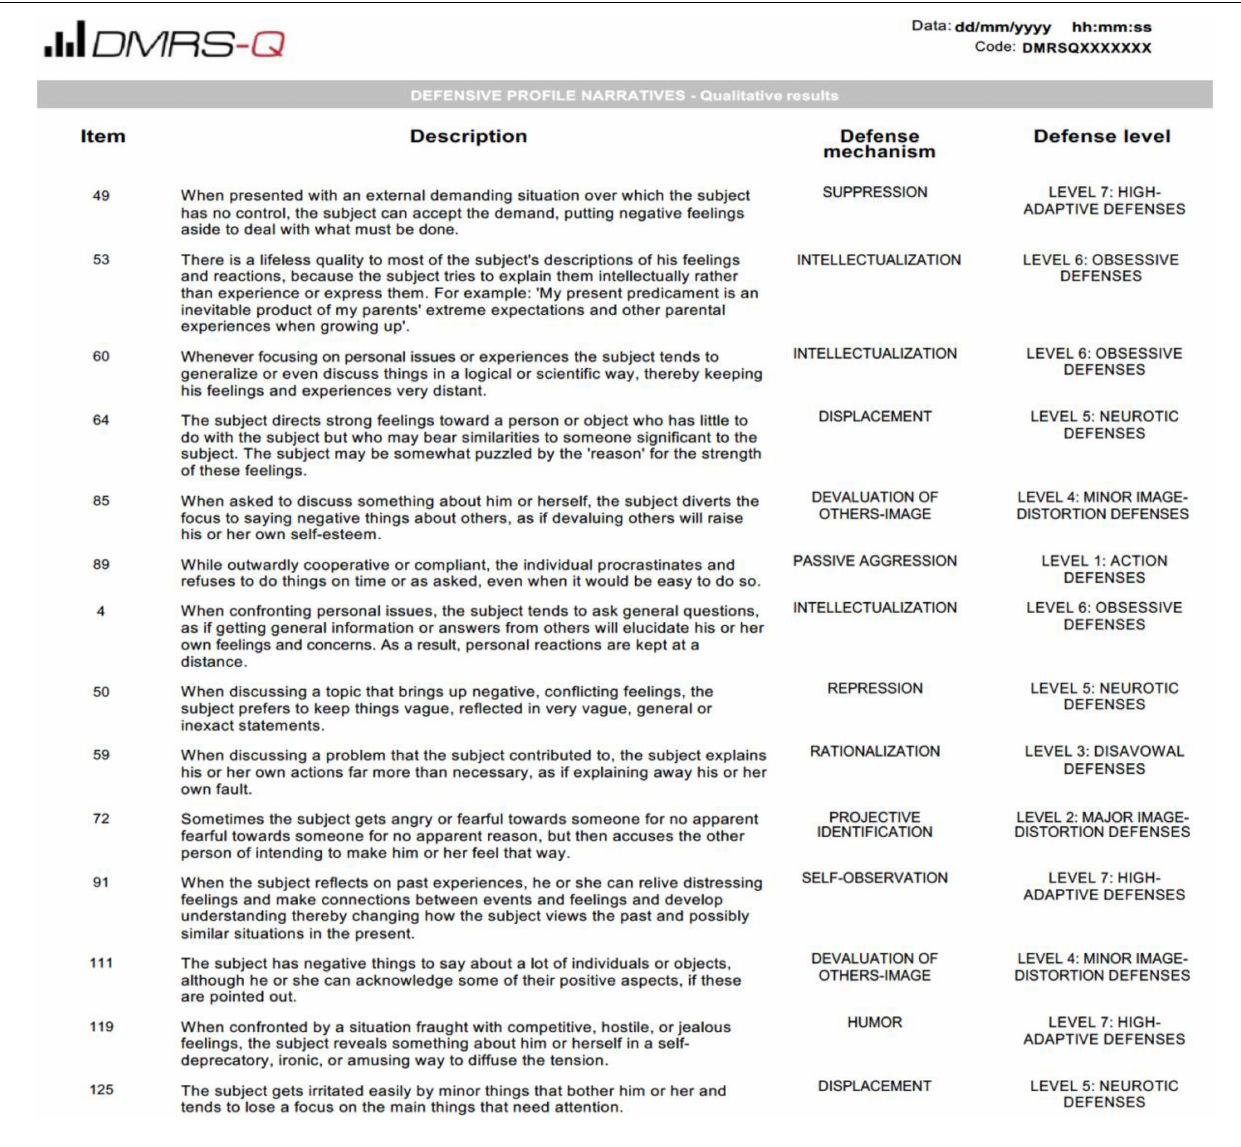
FIGURE 3 | Defensive Profile Narrative (PDN) of a patient assessed with the